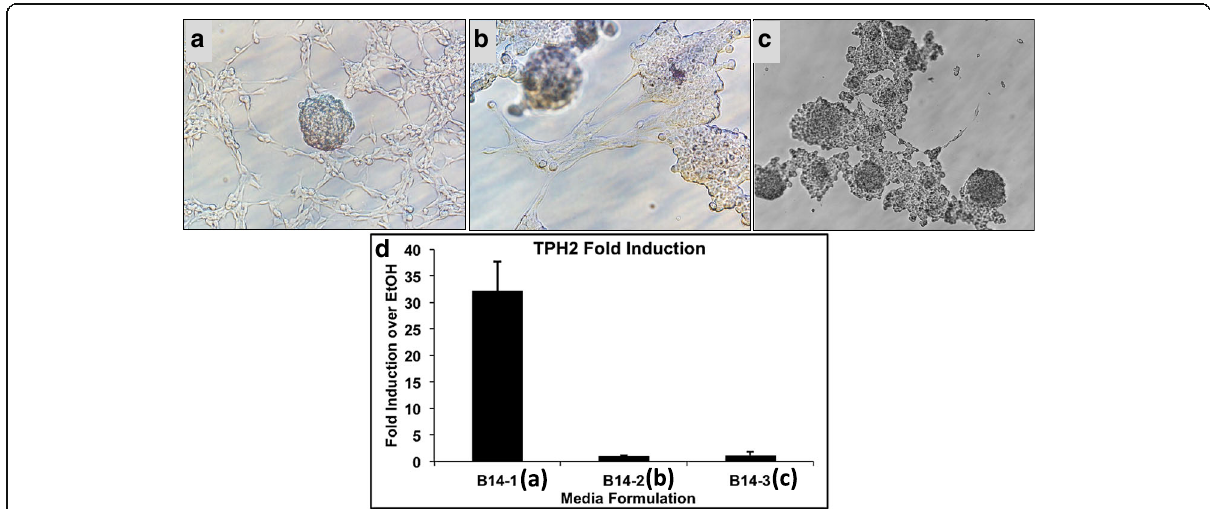
Fig. 3 Morphology of serotonergic rat raphe RN46A-B14 cells grown in a media 1, b media 2, and c media 3, see the “ Methods ” section for descriptions of the media formulations. d RN46A-B14 cells grown in media 1 – 3 and treated with 10 nM 1,25D for 24 h, followed by TPH2 mRNA quantification, expressed as fold relative to EtOH vehicle control (not shown)